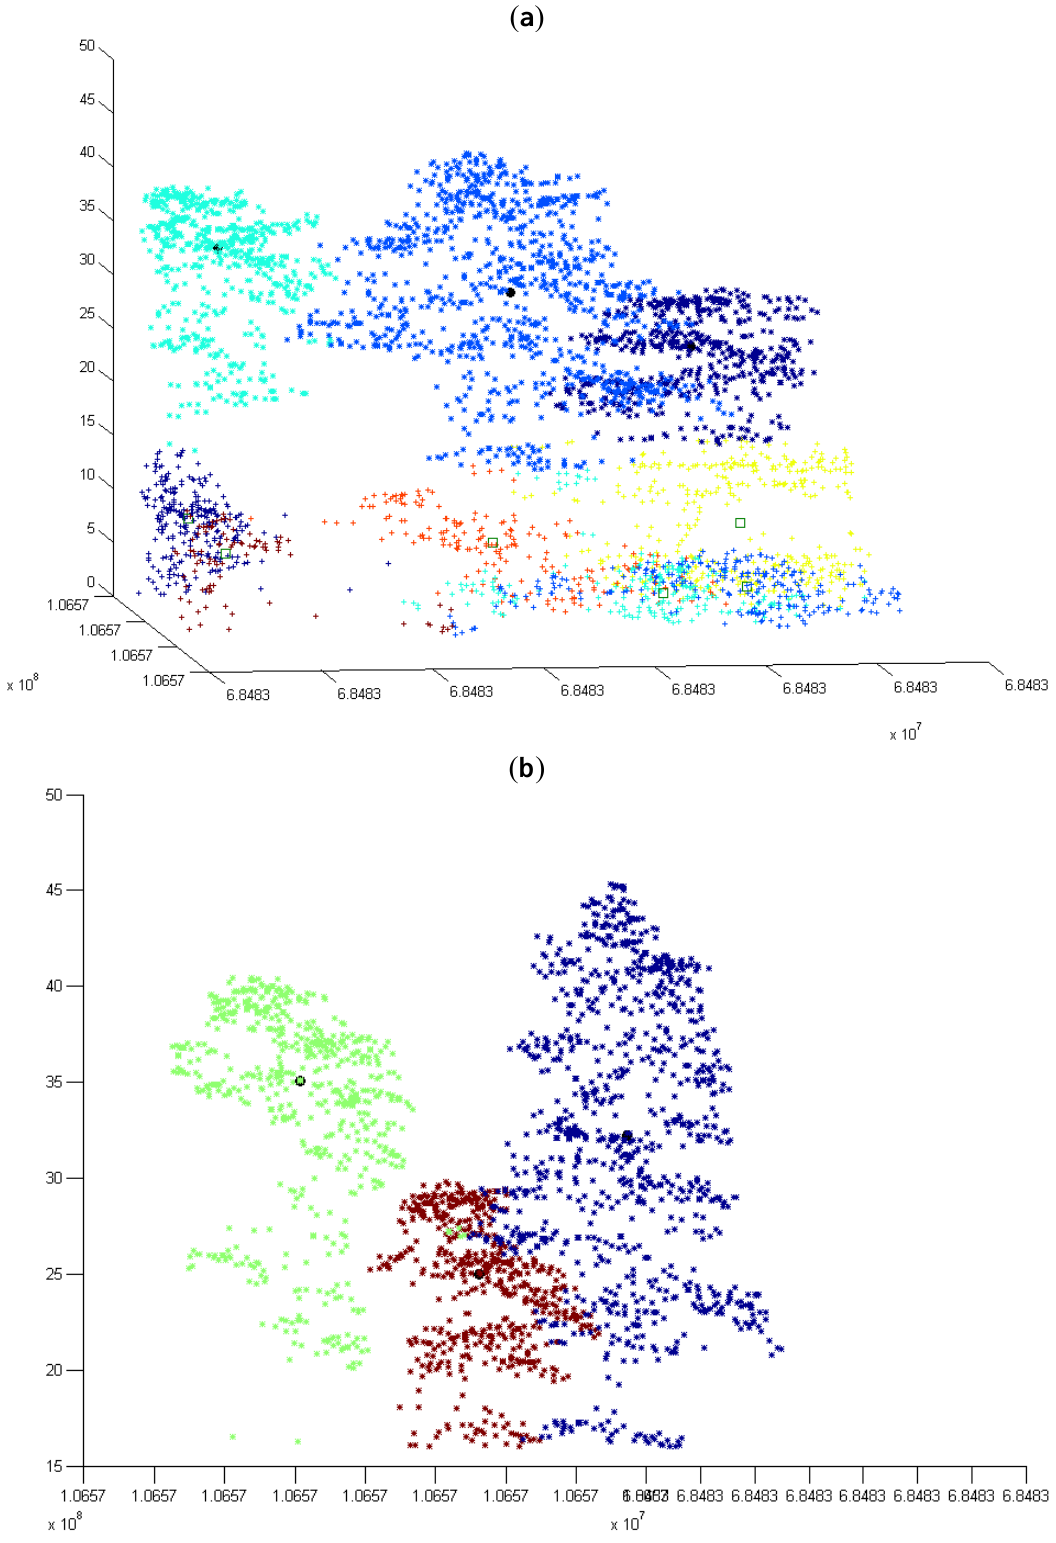
Figure 9. Result after running N k -means by scaling down the height value on two datasets of Cell 6 at different height levels. ( a ) Cell 6 – tree clusters from N k -means in two height classes (between 2 and 16 m and above 16 m). ( b ) Cell 6 – tree clusters from N k -means above 16 m height. The x and y coordinate values (in meters) are displayed horizontally and the z value (in meters) is displayed